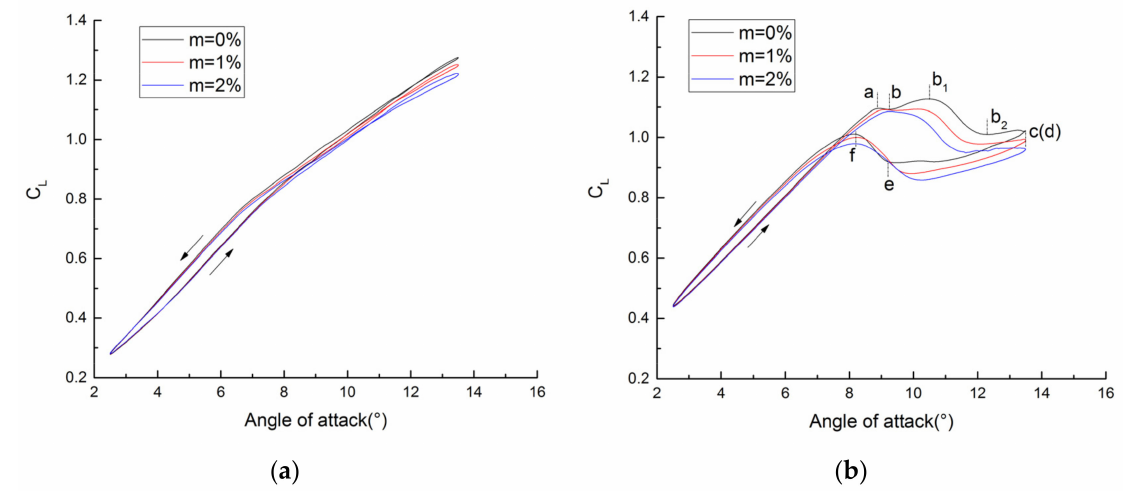
Figure 6. Lift coefficient hysteresis loops of two airfoils for Case 1: ( a ) NACA0012 airfoil; ( b ) S809 airfoil.